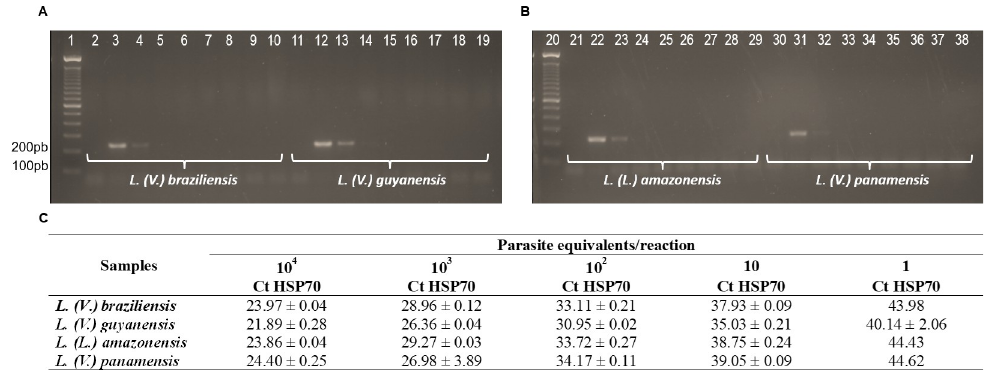
Fig 1. Sensitivity comparison of conventional PCR and qPCR for HSP70 target. (A) Electrophoresis results of cPCR for L . (V . ) braziliensis and L . (V . ) guyanensis : 1: ladder 100 pb; 2: Negative control; 3 to 10: serial dilution from 10 4 to 10 − 3 par. eq./reaction of L . (V . ) braziliensis , respectively; 11: Negative control; 10 to 19: serial dilution from 10 4 to 10 − 3 par.